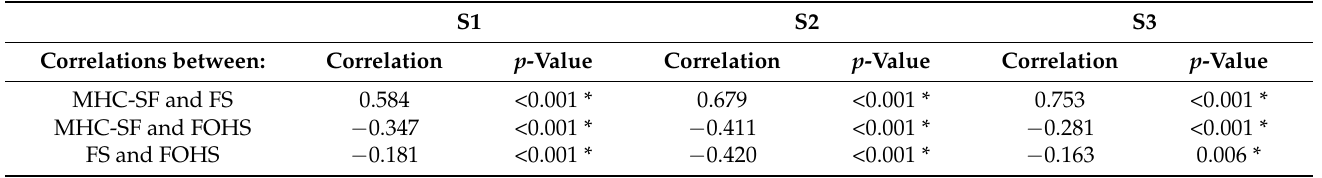
Table 7. Spearman correlations between overall